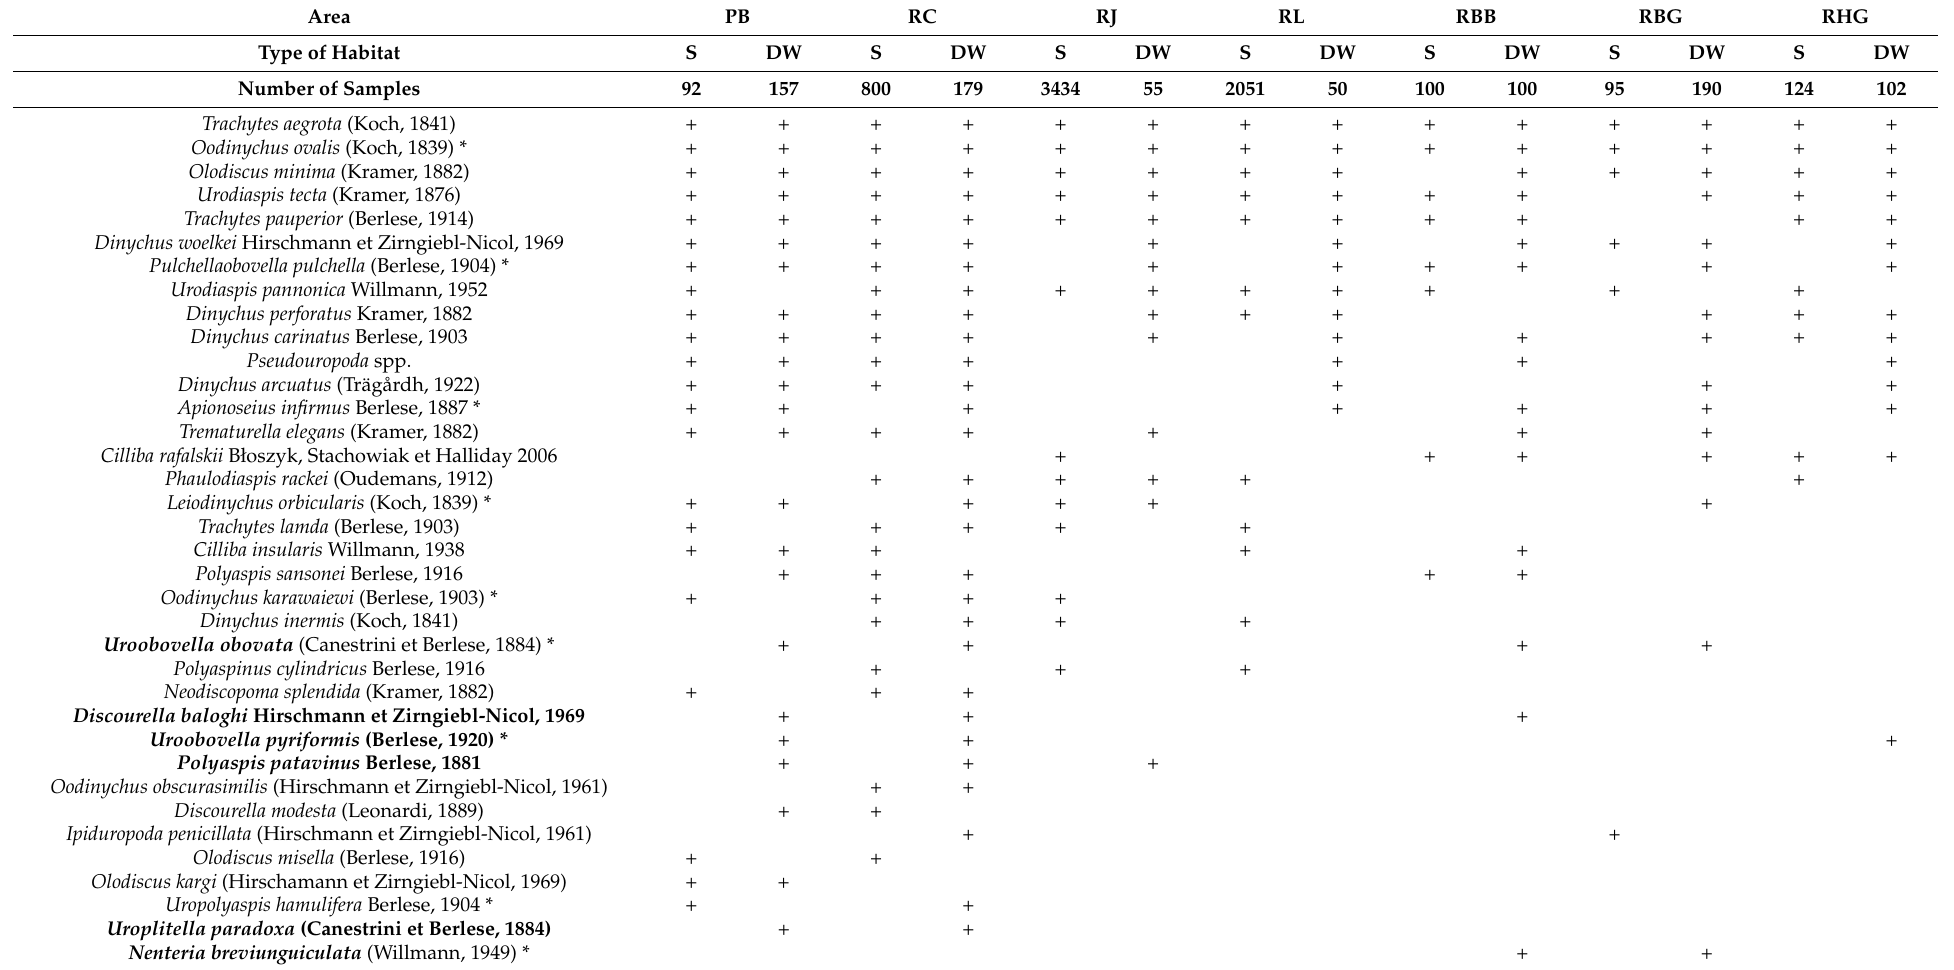
Table 2. Species composition of uropodine mite communities the in examined areas. PB—Białowie˙za Primeval Forest, RC—Cisy Staropolskie im. Leona Wycz ó łkowskiego Nature